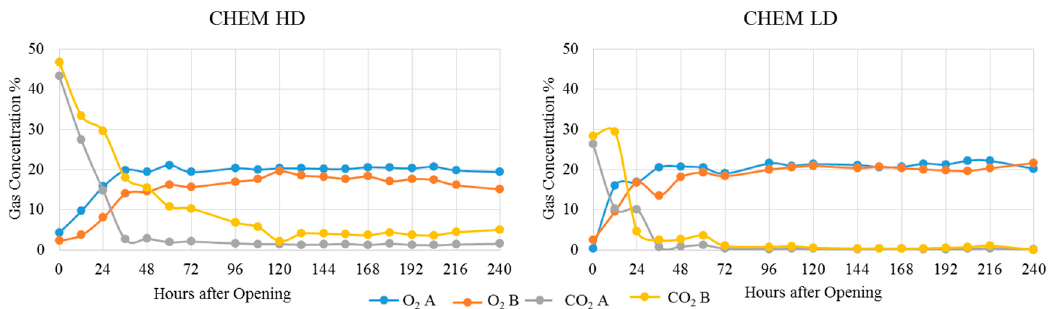
Figure 4. Means of gas concentrations of samples taken from buckets of the chemical treatment at two sampling points (A and B); CHEM = silage treated with chemical additive, HD = high density, LD = low density.